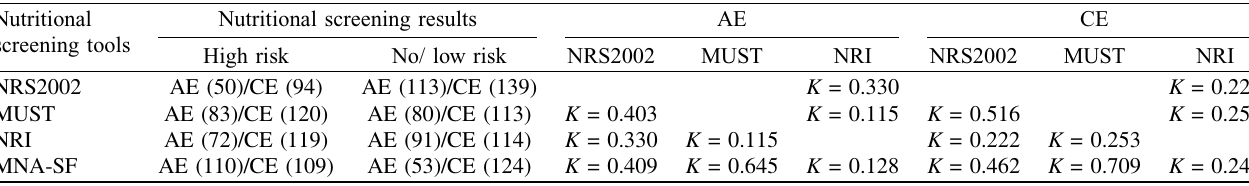
Table 4. Consistency test of three nutritional screening and ESPEN standard. Nutritional Nutritional screening results screening tools